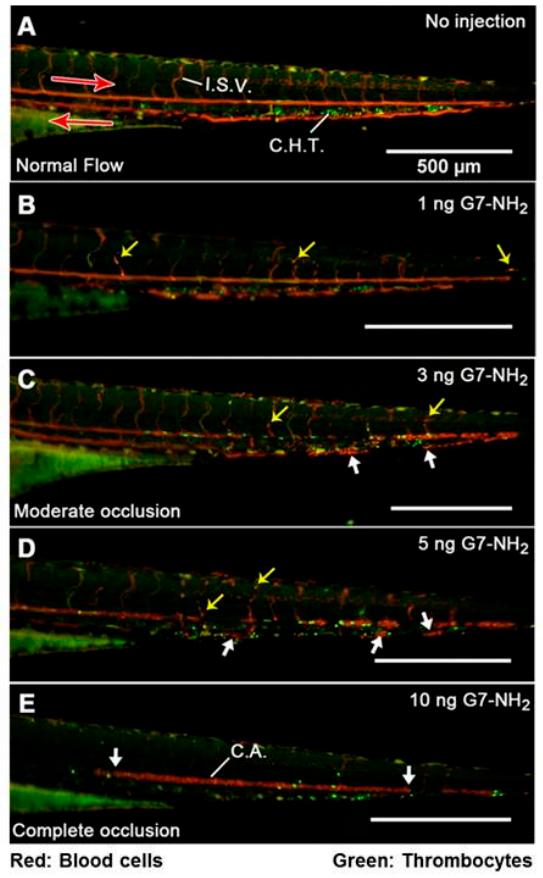
Figure 4. Dose-dependent G7-NH 2 occlusion in zebrafish embryos 1 min post injection. The top panel ( A ) depicts unperturbed caudal blood flow as streaks of red and green light visible in the major caudal artery (CA, left to right), vein (right to left), and intersegmental vessels. Punctate green and red spots in between the major caudal artery and vein indicate the location of the caudal hematopoietic tissue. Subsequent images (proceeding downward ( B – E ), with increasing G7-NH 2 dose) depict increased cellular adhesion and vascular occlusion resulting from dendrimer injection, culminating in no visible blood flow following an injection of 10 ng of G7-NH 2 . The yellow arrows depict individual red blood cells trapped inside the vessel, while the large white arrows show significant blood clots inside the vessels. Notice in ( E ) that the caudal artery is completely occluded with no observable flow in the major caudal vein. Figure reproduced with permission from reference [140].